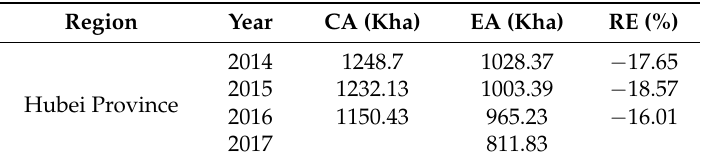
Table 4. Comparison of oilseed rape planting areas derived using the CSRA algorithm and from the agricultural census